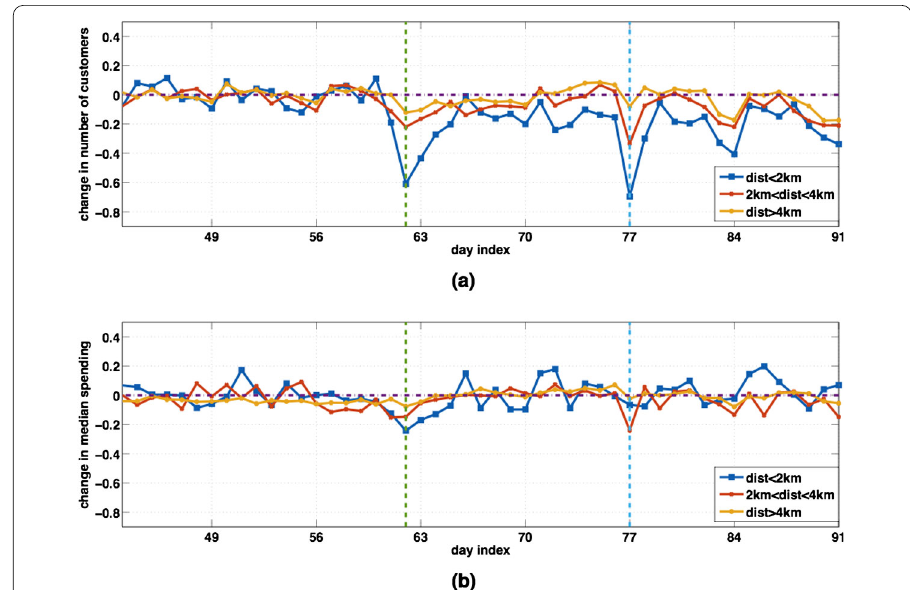
Figure 3 The impact of a series of protest events on the two behavioral indexes, in neighborhoods within 2 km (blue), from 2 to 4 km (red), and above 4 km (orange) from the protest site: ( a ) number of customers; ( b ) median spending. The dash-dot purple line indicates zero change, and the dashed green and cyan lines indicate Day 62 and Day 77, respectively